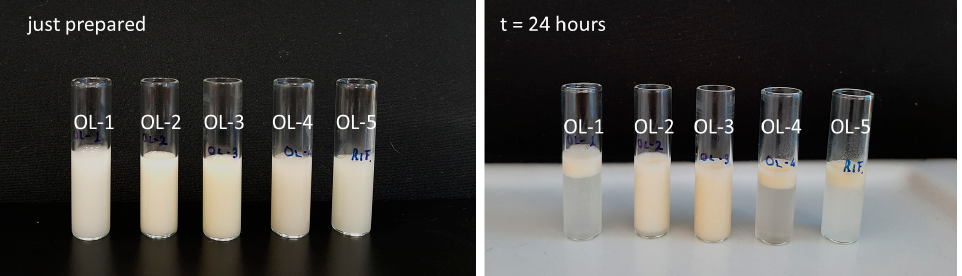
Figure 1. Images of the placebo emulsions immediately after the preparation and after 24 h.